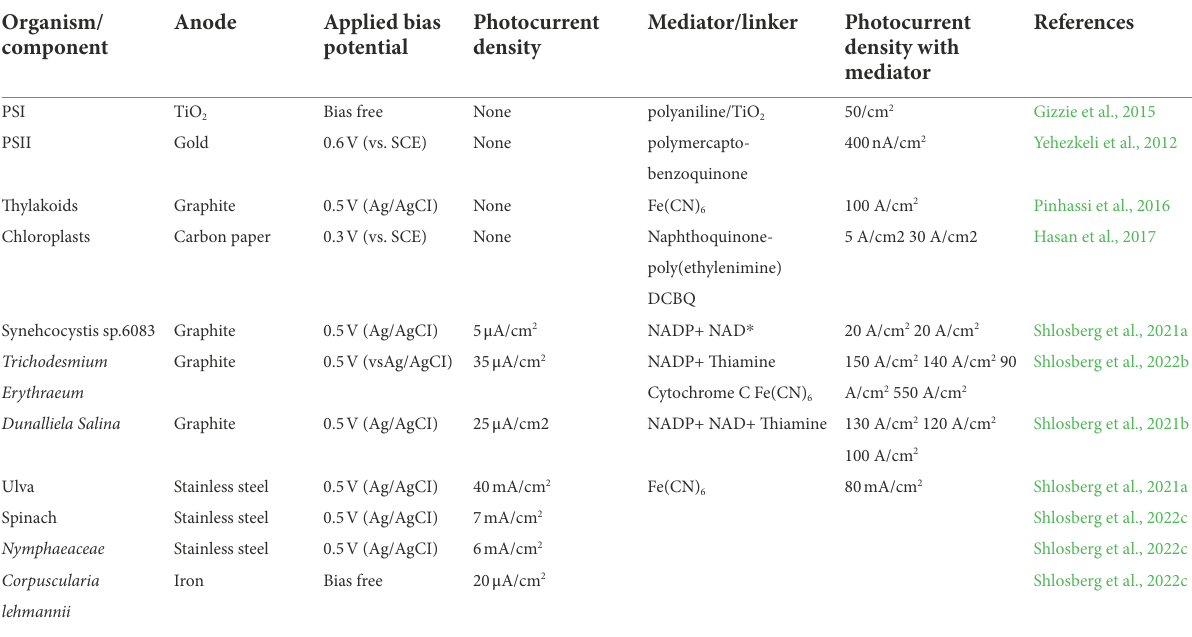
TABLE 1 A comparison between several BPECs.